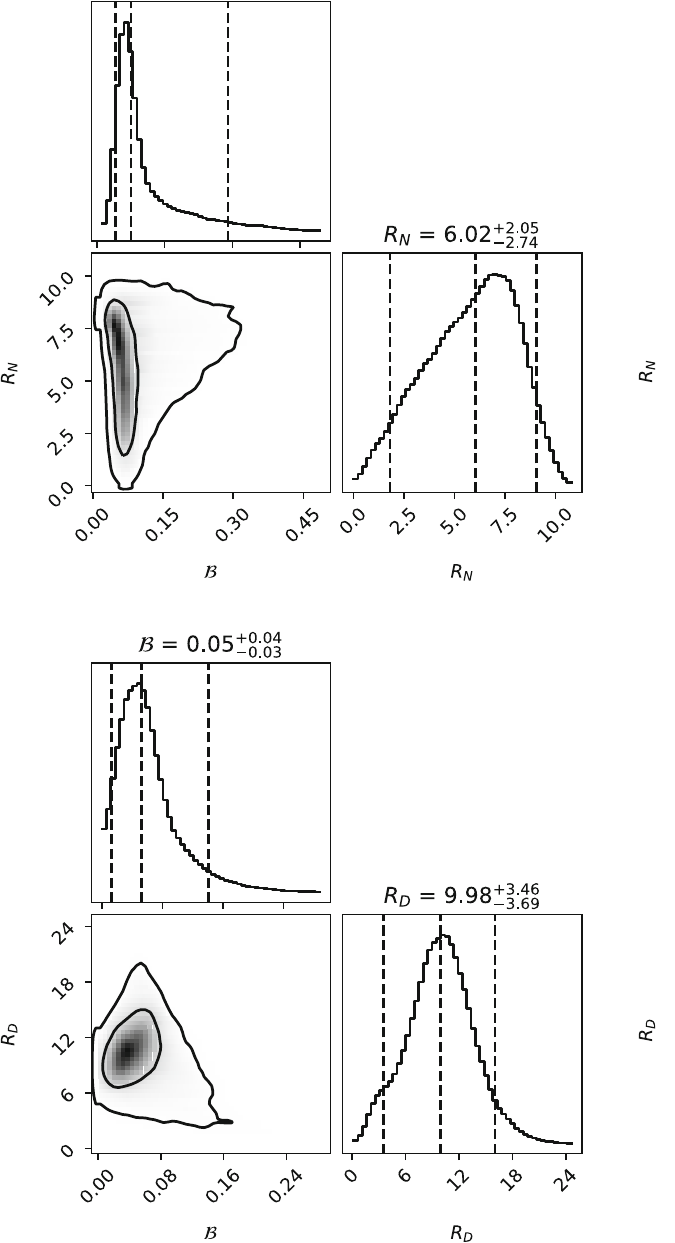
Fig. 16 Posteriors for the dark matter EoS parameter B (horizontal axis) of the SIDM and the core-radius r W (vertical axis) for the first (top sub-figure) and the second (bottom sub-figure) scenarios with neutron SKb EoS. The inferred best-fitted values of B and r W are also given in Table 2 in Figs. 14, 15 and 16, and the inferred best-fitted values are summarized in Table